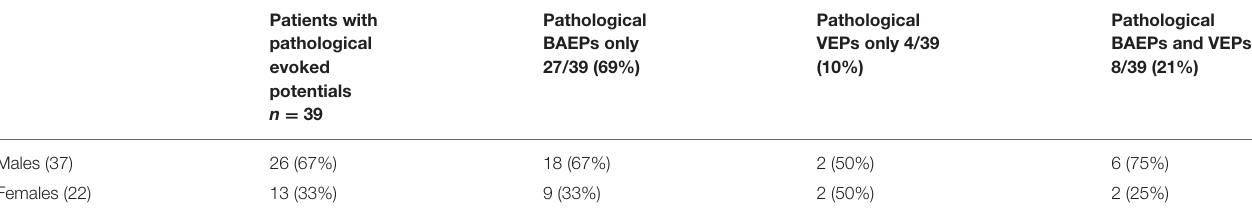
TABLE 2 | BAEPs and VEPs findings in KD patients: 26/37 (70%) of males and 13/22 (59%) of females showed pathological evoked potentials.